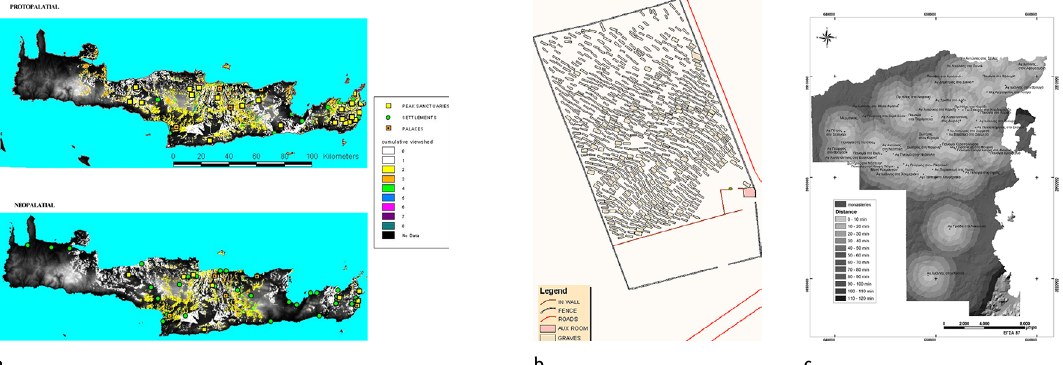
Figure 5: ( a ) Comparison of cumulative viewshed analysis of the Protopalatial and Neoplatial peak sanctuaries in Crete (Soetens et al., 2008). ( b ) Spatial distribution of the graves of the Muslim cemetery of Yeni Mahalle in Komotini, N. Greece. ( c )